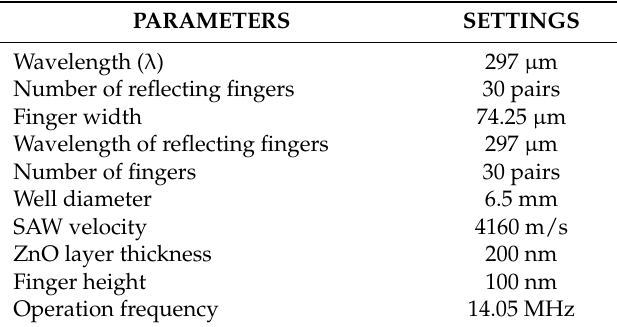
Table 1. Device Parameters used for the simulation and fabrication of the IDT